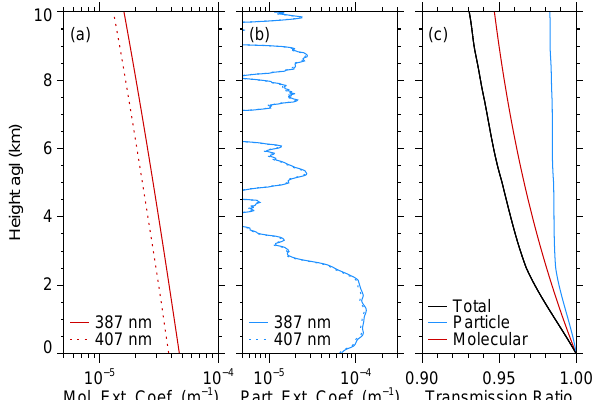
Figure 2. (a) Calculated profiles of the molecular extinction co- efficient at 387 and 407nm. (b) Determined particle extinction coefficient at 387 and 407nm from a Polly XT measurement on 5 May 2013, 23:10UTC. (c) Resulting transmission ratio consid- ering the molecular (red), the particle (blue) contribution and the the sum of both